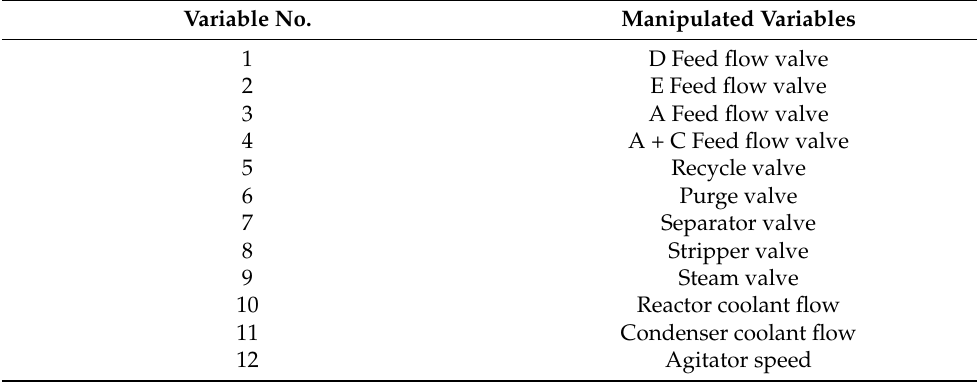
Table 5. Measurement variables in the Tennessee Eastman process.